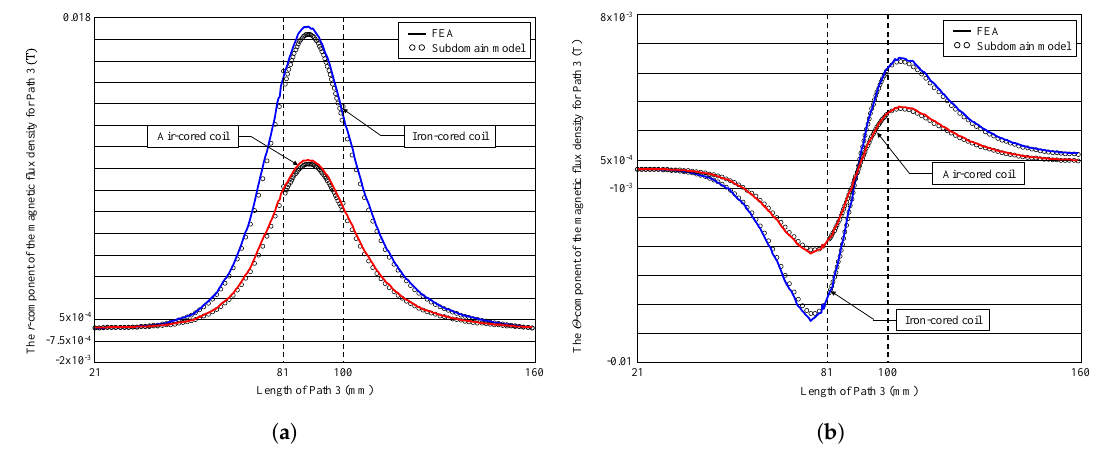
Figure 9. Waveforms of B for Path 3: ( a ) r - and ( b ) Θ